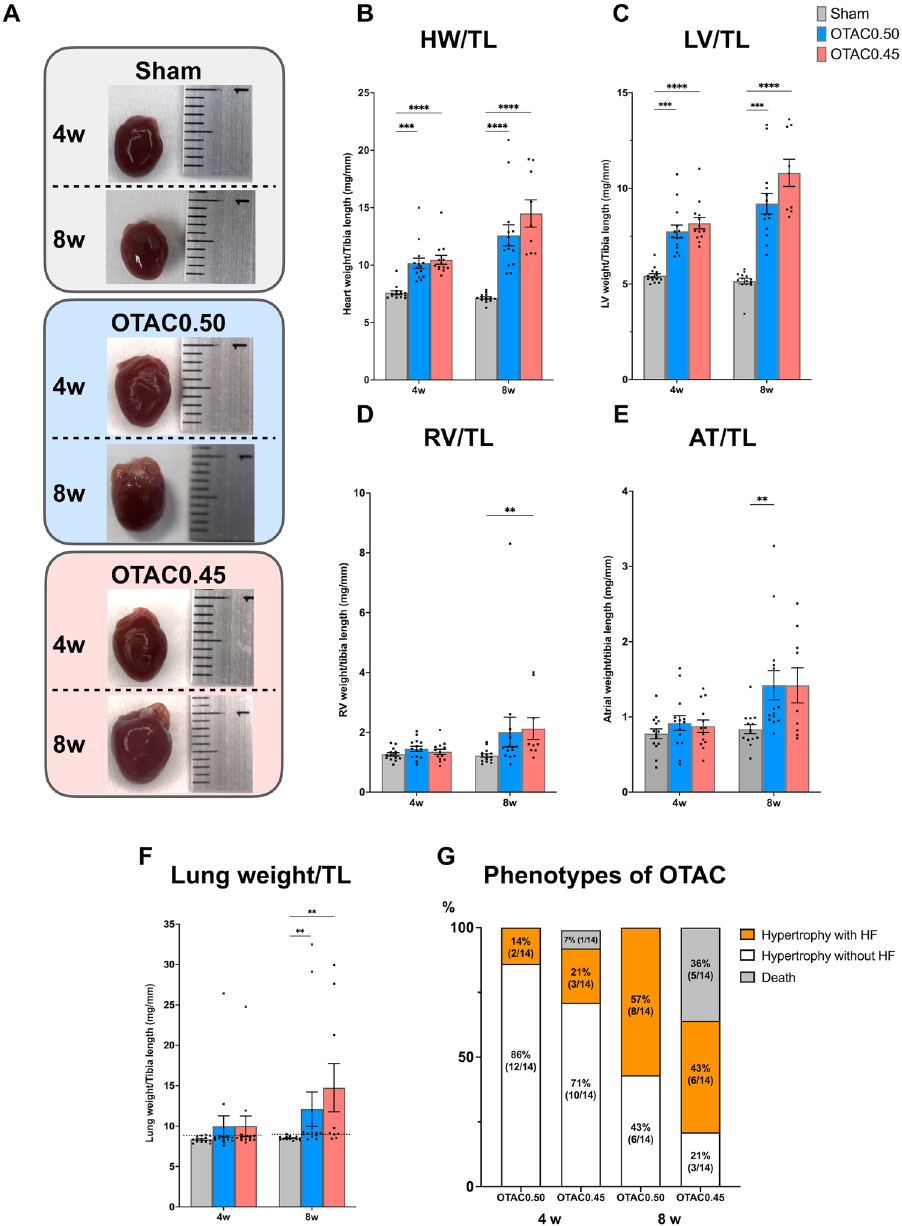
Figure 3. OTAC results in reproducible and graded myocardial hypertrophy. ( A ) Representative images showing cardiac morphology. ( B–E ) Bar graphs showing quantitative data for heart weight (HW)/tibia length (TL) ( B ), left ventricular (LV) weight/TL ( C ), right ventricular (RV) weight/TL ( D ) and atrial (AT) weight/ TL ( E ). OTAC also results in reproducible lung congestion. ( F ) Lung weight normalized to TL. The dotted line indicates a maximum value for Sham mice. ( G ) Variability in cardiac phenotype in response to the duration of OTAC. These data were measured at terminal sacrifice at 4 weeks and 8 weeks after procedures. Data are expressed as the mean ± standard error of the mean. O-rings had inner diameters of 0.50 mm (OTAC0.50) and 0.45 mm (OTAC0.45). Comparison among groups was performed by one-way analysis of variance (ANOVA) with Tukey’s post hoc tests; n = 9–14. ** P < 0.01; *** P < 0.001; **** P <